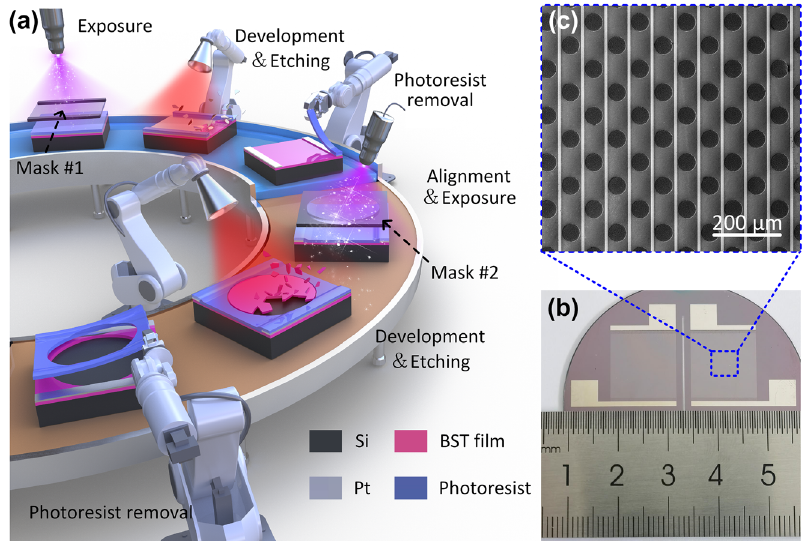
Figure 5: Fabrication process and sample display (a) Schematic diagram of the overlay lithography process. Photograph (b) and SEM image (c) of the fabricated BST – silicon hybrid